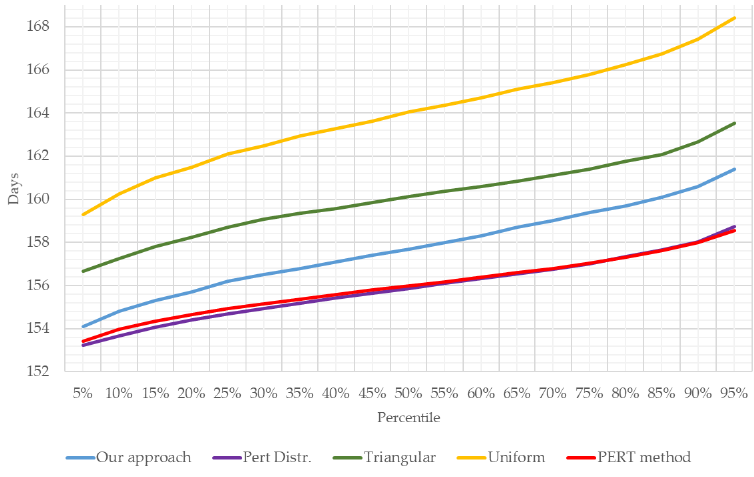
Figure 2. Resulting curves for our approach and the compared methods.